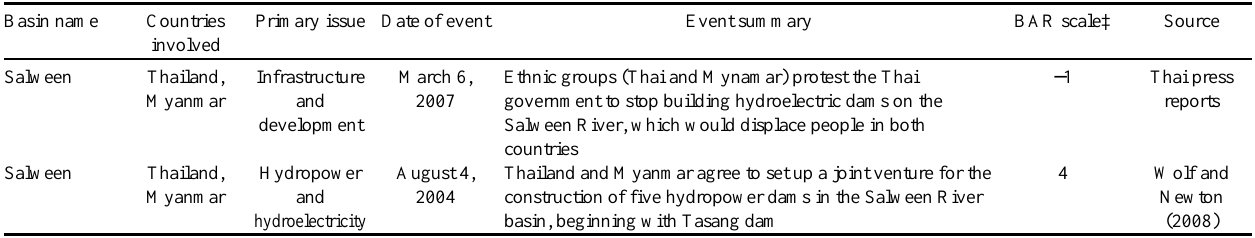
Table 4. Examples of transboundary